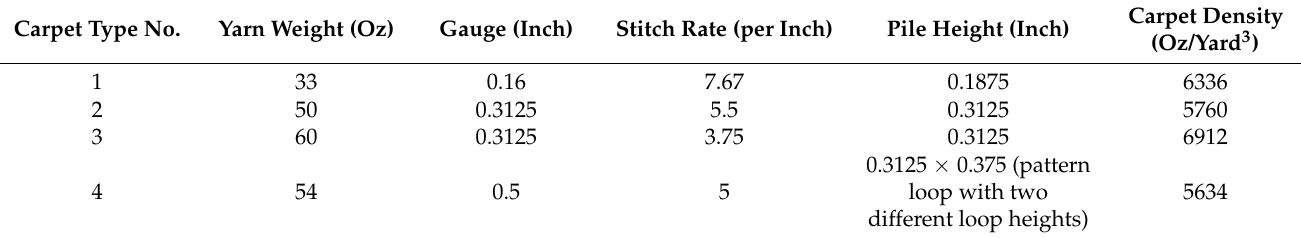
Table 1. Specifications of four different